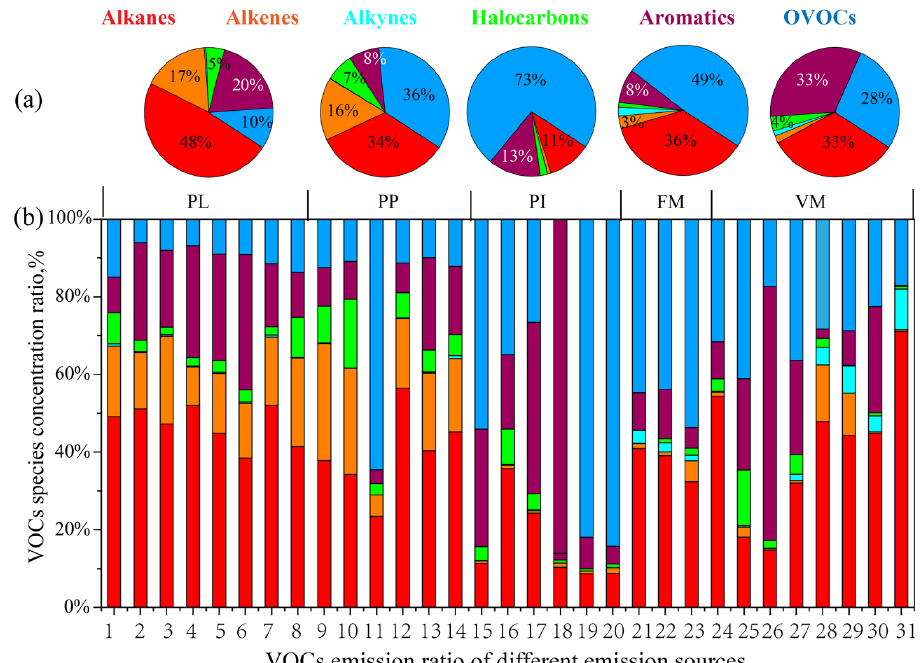
Figure 2. Composition characteristics of VOCs emitted by industry ( a ) and different process links ( b ). (Note: PL: plastic products industry; PP: packaging and printing industry; PI: printing ink industry; FM: furniture manufacturing; VM: vehicle manufacturing industry).